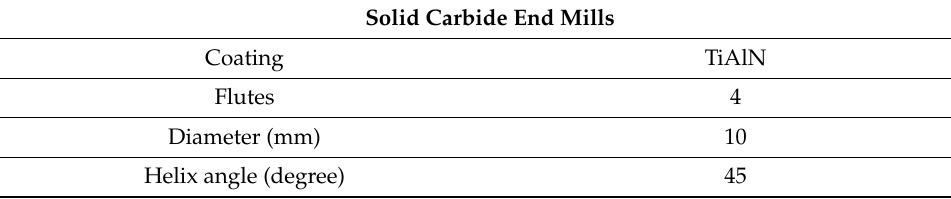
Table 3. Specification of the sensory tool holder.